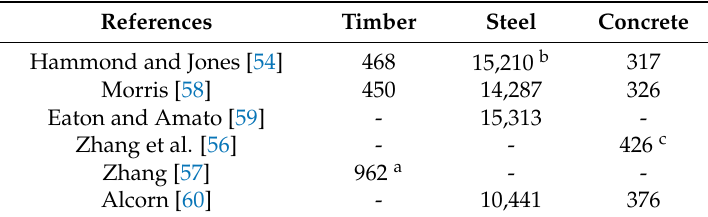
Table 2. Embodied carbon of materials (unit: kg CO 2 e/m 3